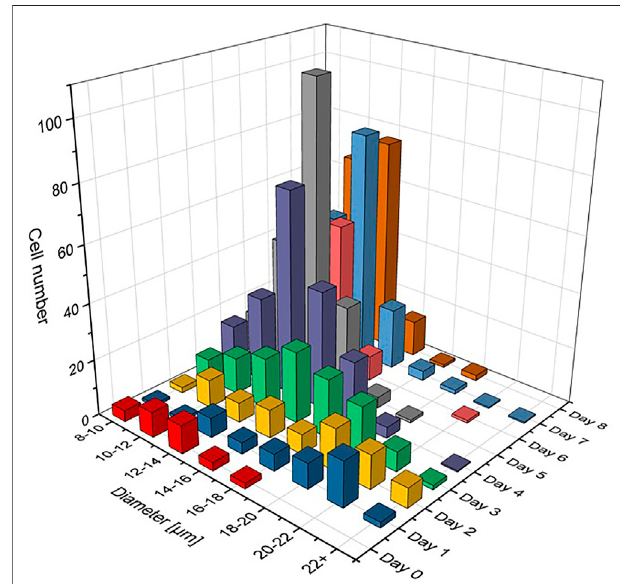
FIGURE3| Cellsizedistributionfunctionswithrelativenumberofcells N i shown for different diameter classes d i having Δ d = 2 µm. The number of cells on each day of the cultivation is like the optical density in OD normalized graphs, Σ N i = OD, so that the growth dynamics of the population from day to day can clearly be